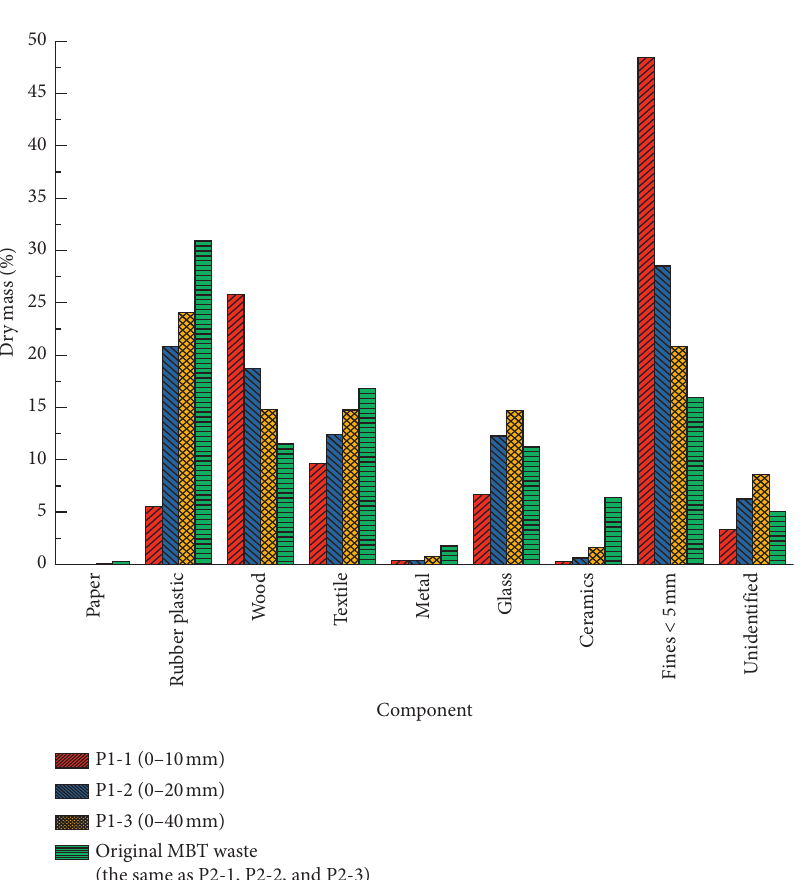
Figure 2: Various components in MBT waste samples with different particle